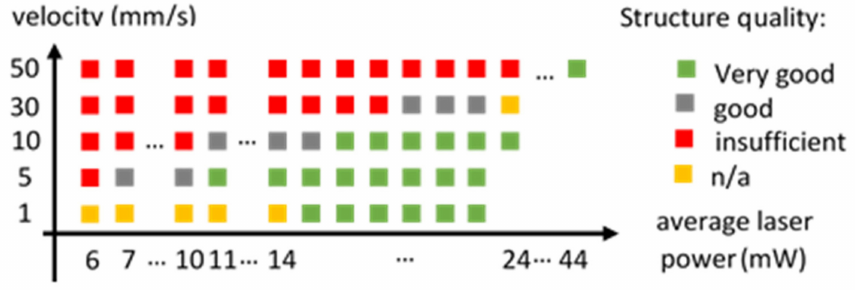
Figure 3. Parameter space for structuring cuboids (20 µ m × 20 µ m × 30 µ m) with TPA using ATZ